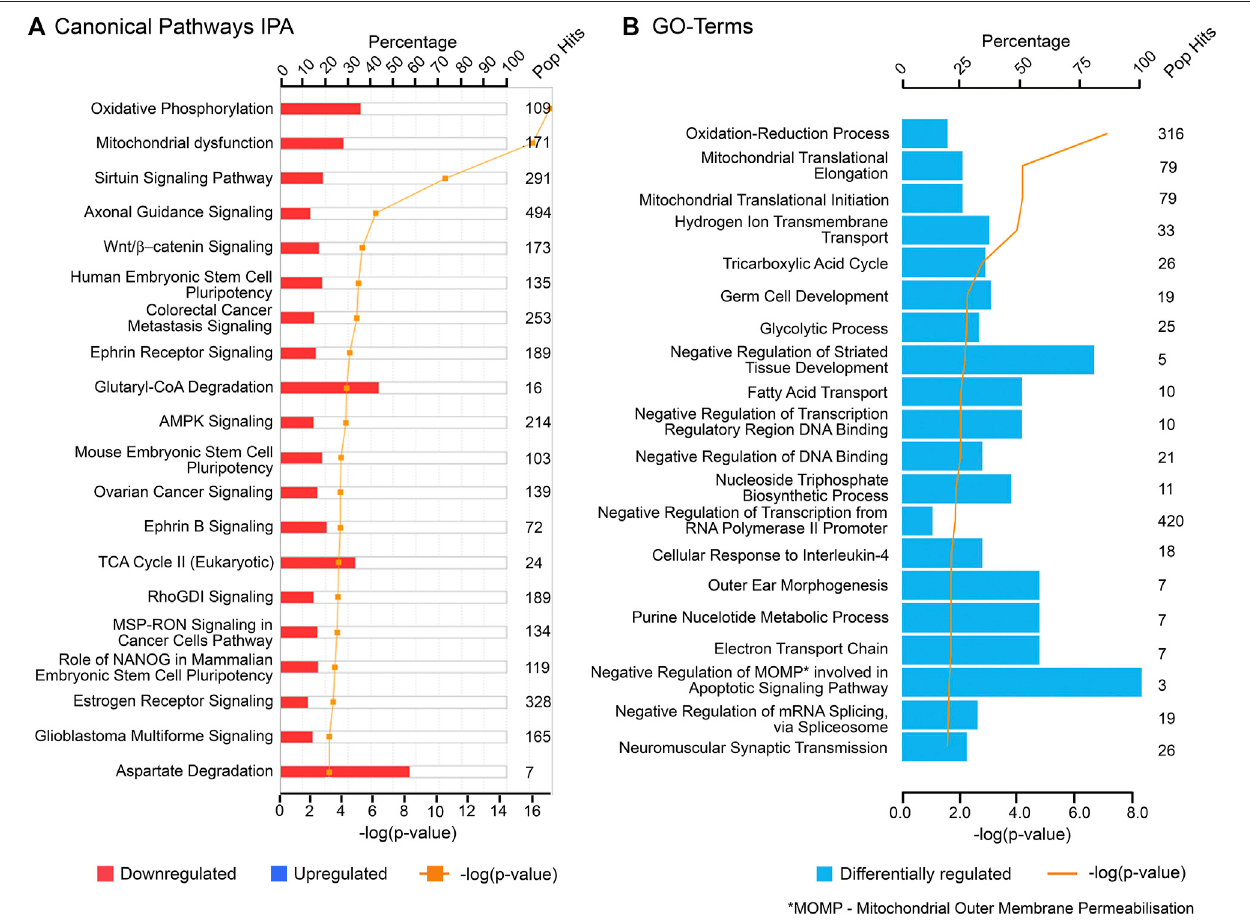
FIGURE 3 | Top canonical pathways associated with cluster 1 ( “ early ” genes) using (A) Ingenuity Pathway Analysis (IPA) and (B) Gene Ontology (GO) biological processes from DAVID database. “ Pop Hits ” refers to the total number of genes associated with each of the pathway in the database. The bar graphs represent the percentageofgenesfromthedatasetthatmaptoeachcanonicalpathwaywhilsttheorangelineshowsthe p -valueofoverlapbetweengenesineachclusterandagiven pathway.